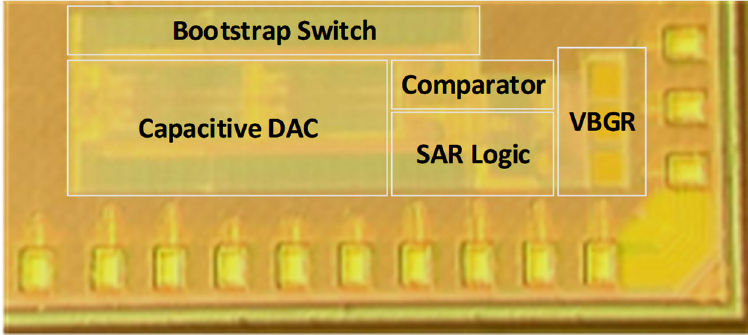
Figure 13. Die photograph of the asynchronous SAR ADC with VBGR.